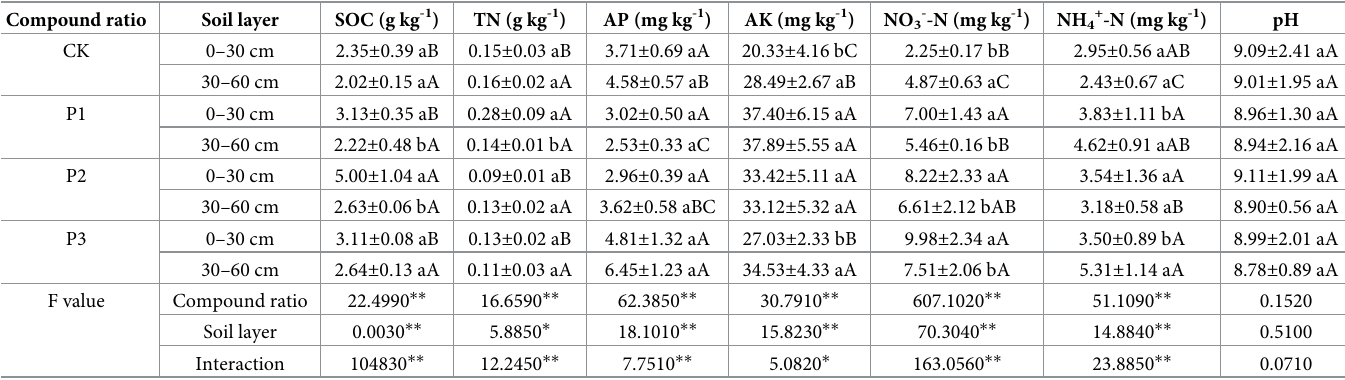
Table 1. Vertical distribution characteristics of soil physical and chemical properties under different compound ratio treatments. Compound